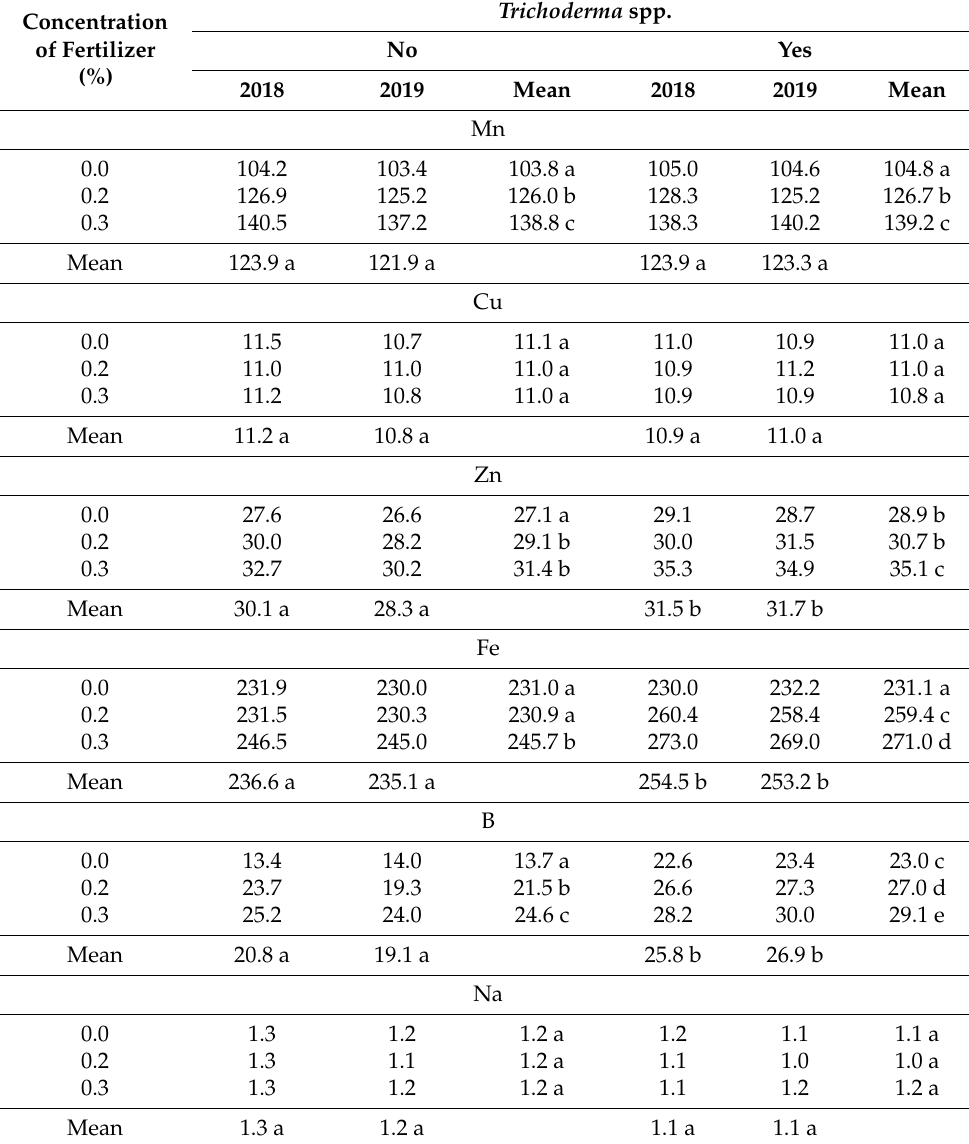
Table 4. Content of microelements (MG k DW) in leaves of Begonia × tuberhybrida ‘Picotee Sunburst’ after application of Trichoderma spp. and different fertilization level. Means followed by the same letter for column-wise and row-wise do not differ significantly at α =